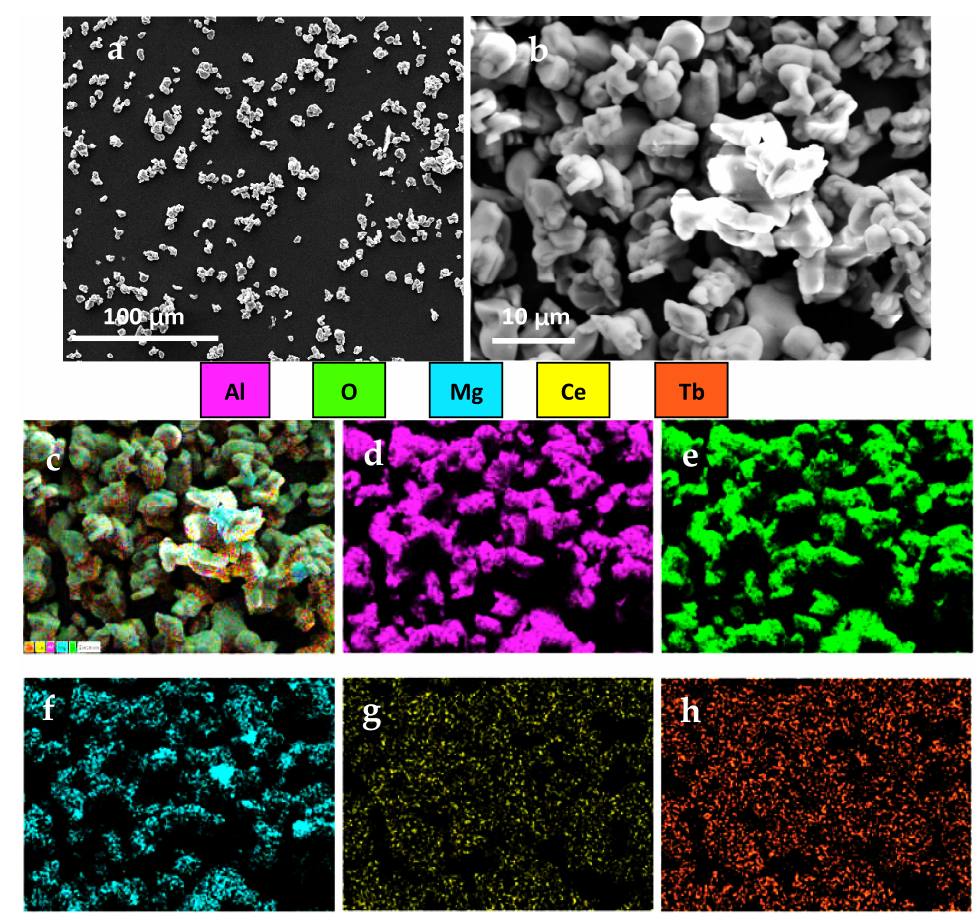
Figure 3. SEM images of CMAT with various magnification. ( a ) 500×, ( b )1000×, ( c ) 5000×, ( d ) Al, ( e ) O, ( f ) Mg, ( g ) Ce, and ( h ) Tb.